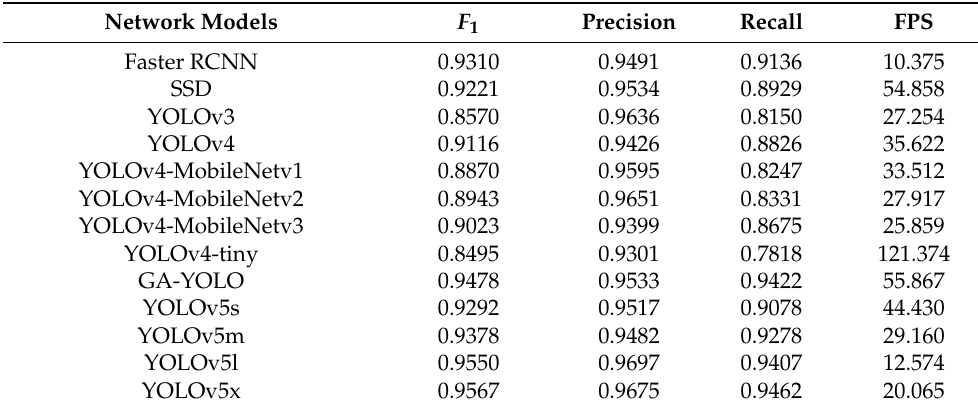
Table 9. Comparison of calculation volume, parameter volume, and weight file of different network models.